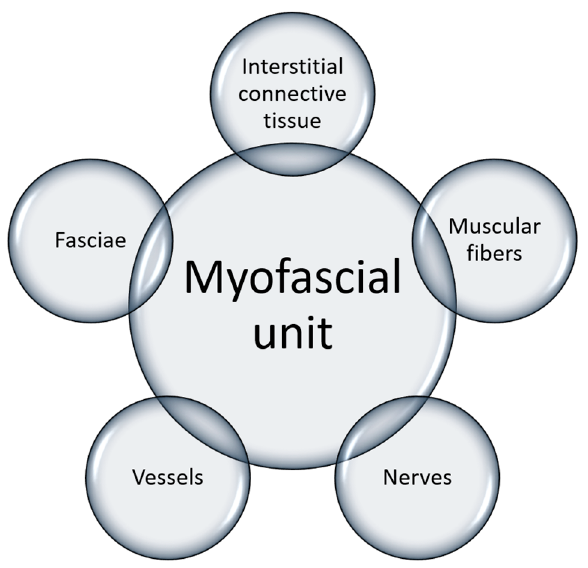
Figure 2. The myofascial unit composition.